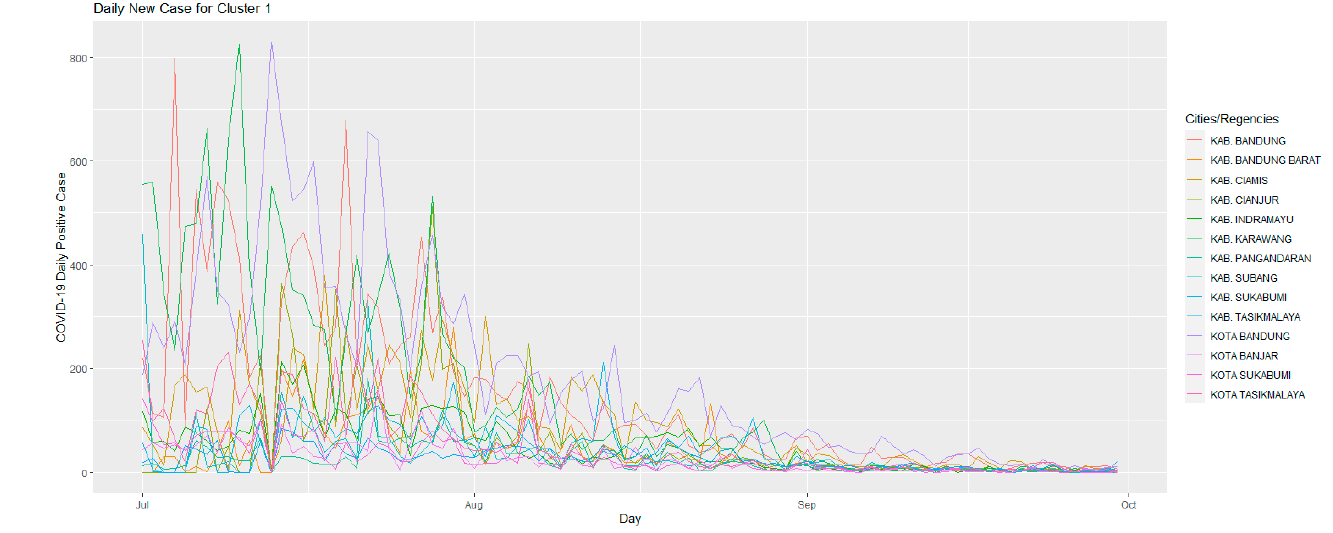
Figure 4. Daily positive cases of COVID-19 in cluster 1 for the first period.